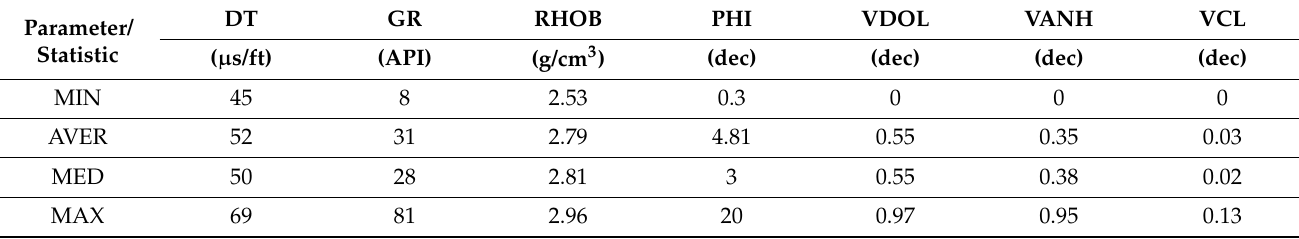
Table 2. Simple statistics (MIN—minimum, AVER—average, MED—median, MAX—maximum) of the petrophysical parameters obtained from the well logging measurement and interpretation in the G-5 borehole.